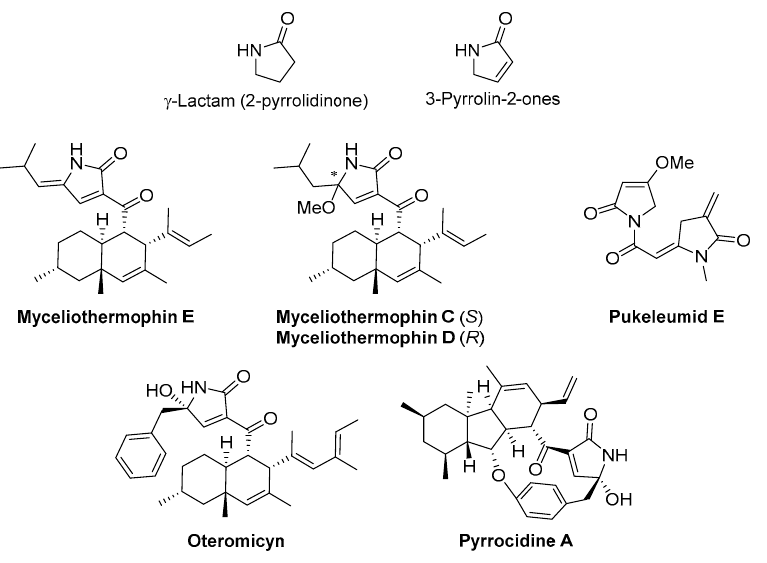
Figure 1. Relevant γ -lactam-containing